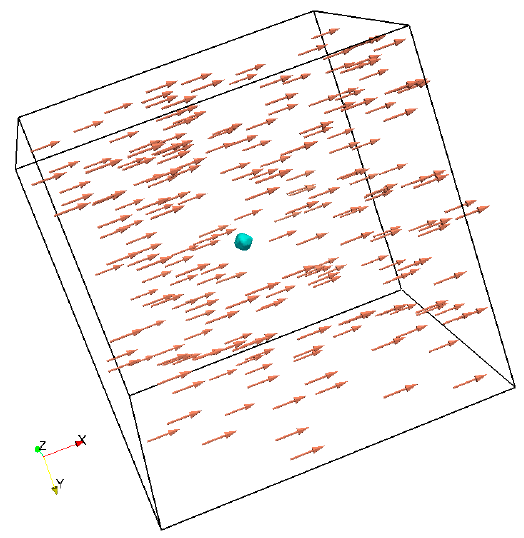
Figure 1. Initial snapshot of the simulation domain with velocity vectors of the melt flow.